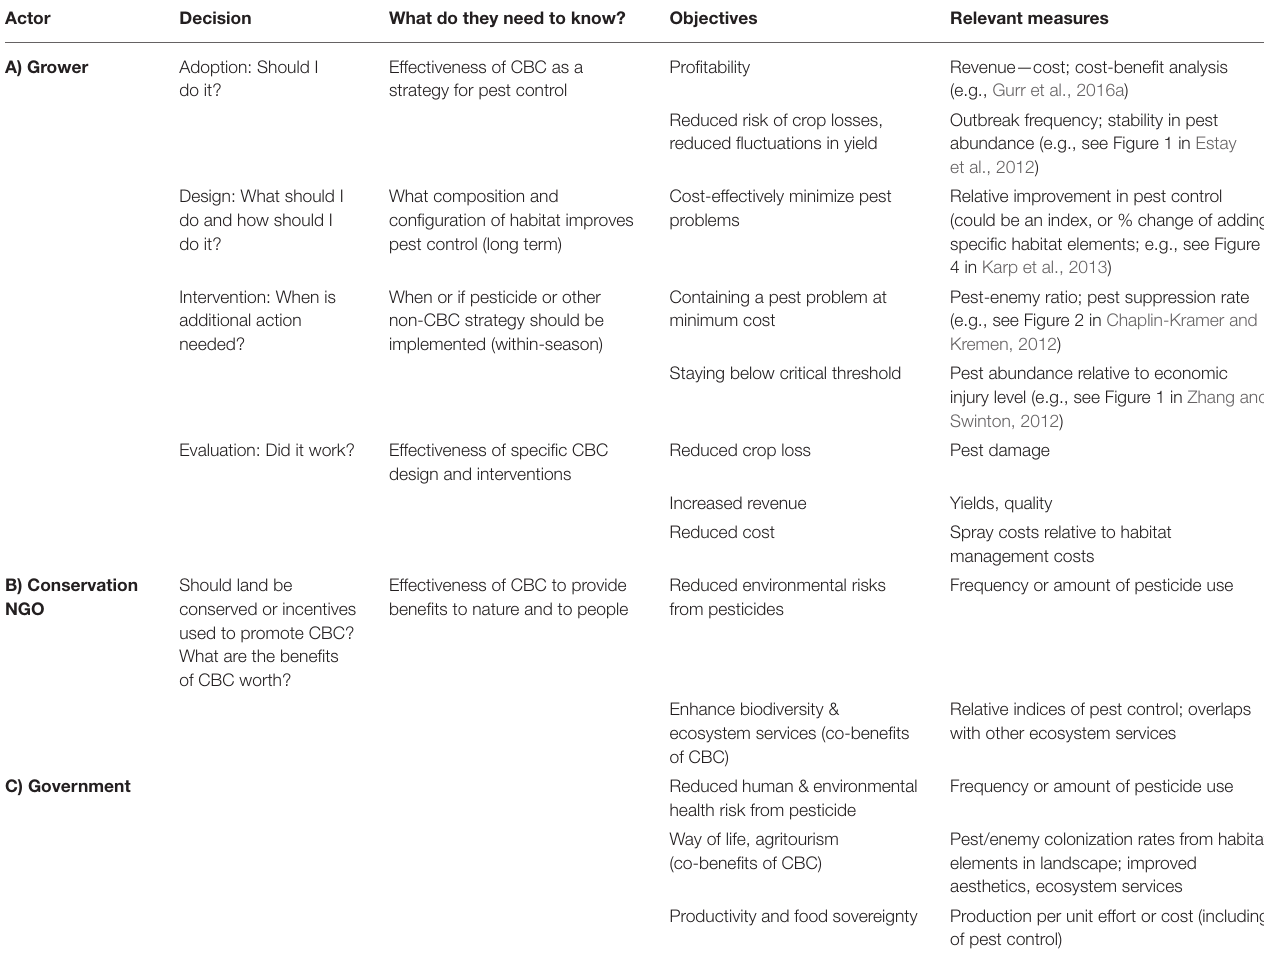
TABLE 1 | Description of conservation biocontrol (CBC) measures to address the objectives of decision-makers in agricultural landscapes.